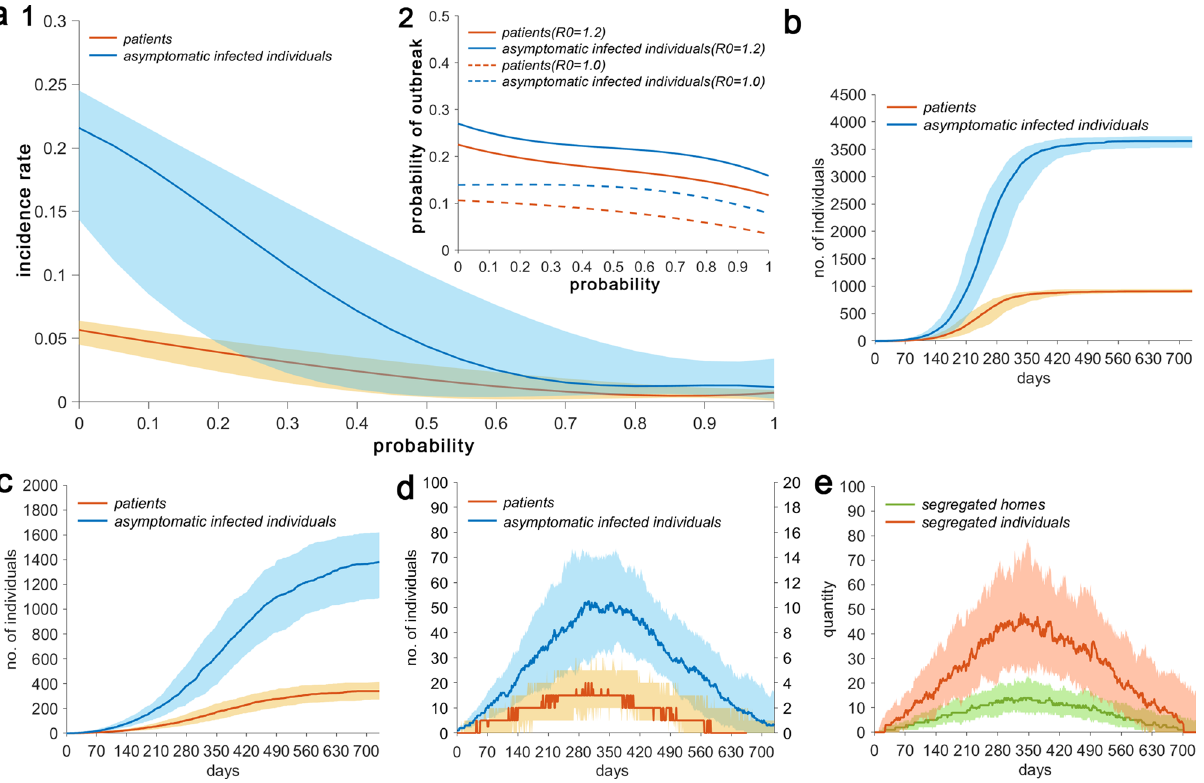
Figure 1. Transmission of an epidemic caused by one case of imported AII. ( a1 ) Considering R 0 = 1.2, p = 0.2, t = 730 days, and in the presence of prevention and control measures, the effect of parameter q on the infection rate of AIIs, and incidence rate of patients during an epidemic outbreak (cumulative number of new AIIs more than 20 or cumulative number of new patients more than 10). ( a2 ) Considering R 0 = 1.2, 1.0, and in the presence of measures, the effect of parameter q on the probabilities of AIIs and patients causing an epidemic outbreak. ( b ) Considering R 0 = 1.2, and in the absence of any measures, the temporal distribution of the cumulative number of new AIIs and patients during an epidemic outbreak. ( c ) Considering R 0 = 1.2, and in the presence of measures, the temporal distribution of the cumulative number of new AIIs and patients during an epidemic outbreak. ( d ) Considering R 0 = 1.2, and in the presence of measures, the temporal distribution of the number of undetected AIIs and patients. ( e ) Considering R 0 = 1.2, and in the presence of measures, the temporal distribution of the number of quarantined households and residents during an epidemic